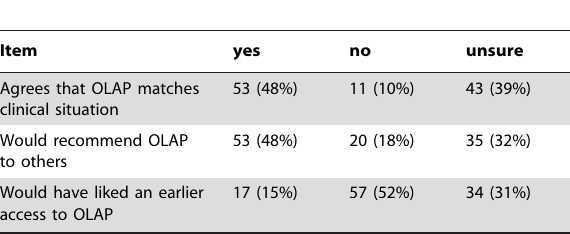
Table 2. Acceptance of the OLAP